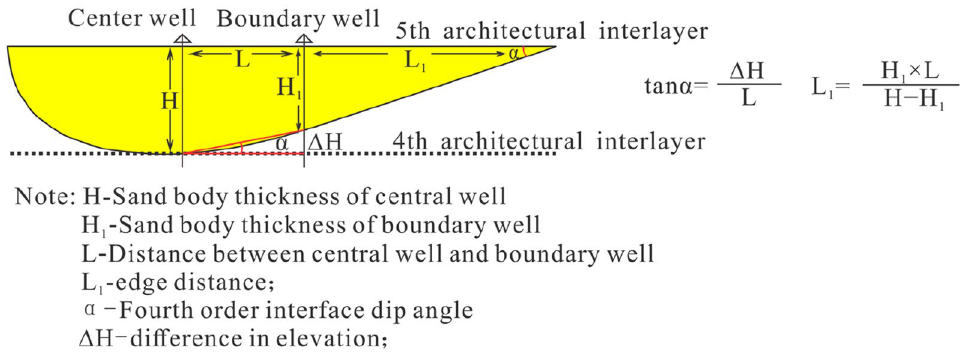
Figure 3. Geometric form prediction method of architectural elements. Note This model is a single channel thickness prediction model (modified from reference 49